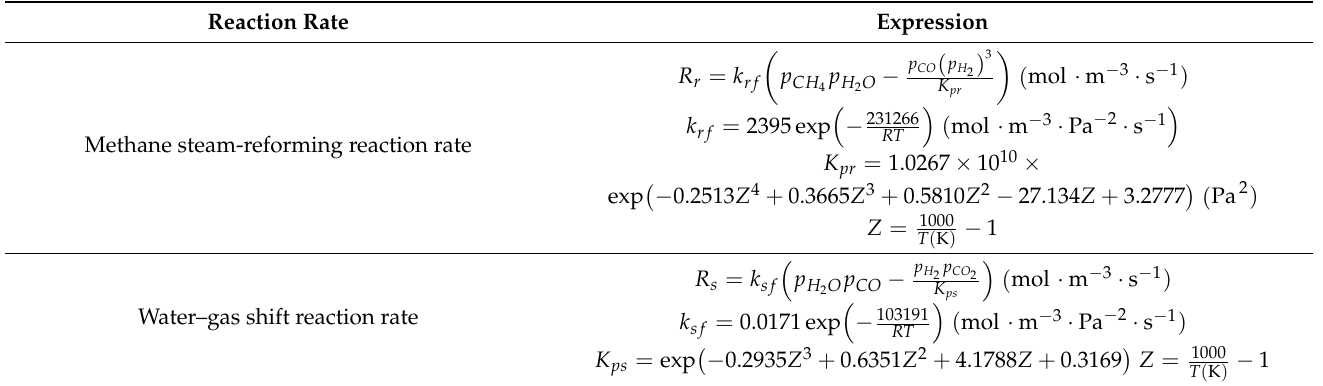
Table 1. Equations for reaction rates [26]. Reaction